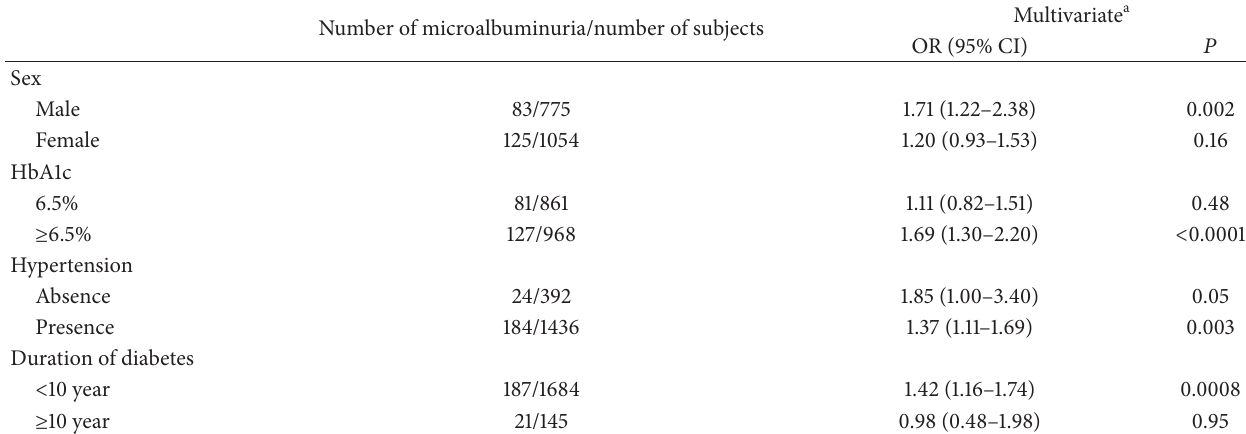
Table 3: The risk of microalbuminuria with each tertile decline of serum Mg in different subgroups of diabetic patients. Number of microalbuminuria/number of